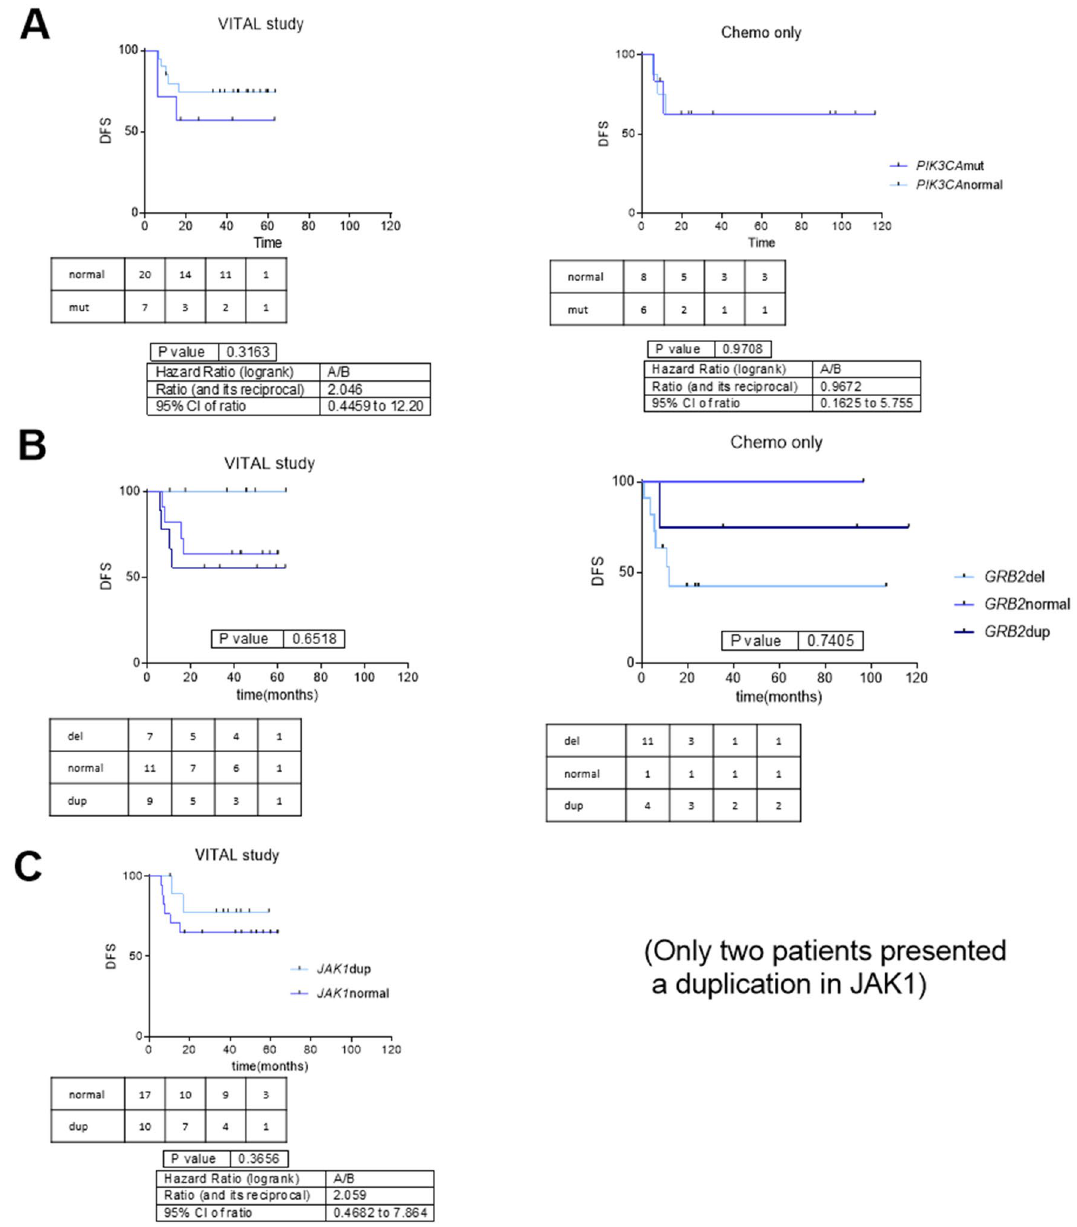
Figure 2. Disease-free survival curves for relevant genetic variants in pharmacodynamics pathway of EGFR inhibitors. ( A ) Disease-free survival curves for patients with high- and moderate-impact genetic variants in PIK3CA versus PIK3CA wild-type in patients from the VITAL clinical trial and from the chemoradiotherapy cohort. ( B ) Disease-free survival curves for VITAL clinical trial and chemoradiotherapy cohort patients according to GRB2 status. HR between normal-duplicated vs deletion = 4.19 (CI95% 0.92–19.2). ( C ) Disease- free survival curves for VITAL clinical trial patients according to JAK1 status. DFS Disease-free